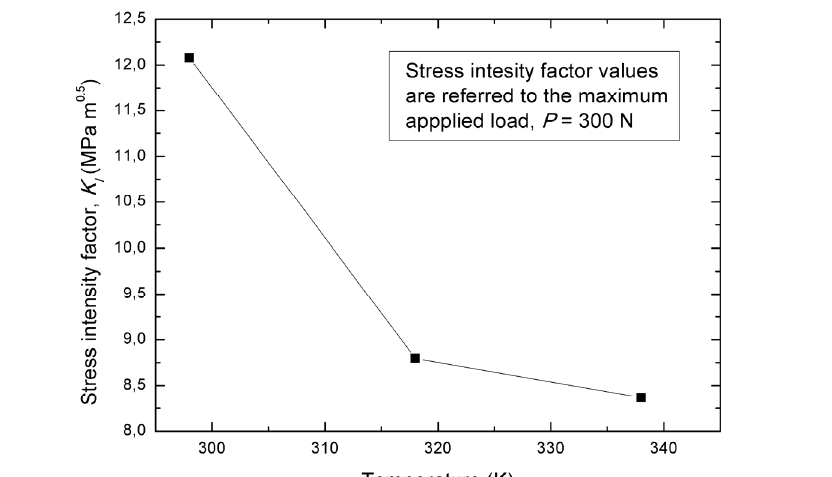
Figure 5: Evolution of the Stress Intensity Factor (SIF), recorded at the maximum applied load ( P =300 N), as a function of the operating